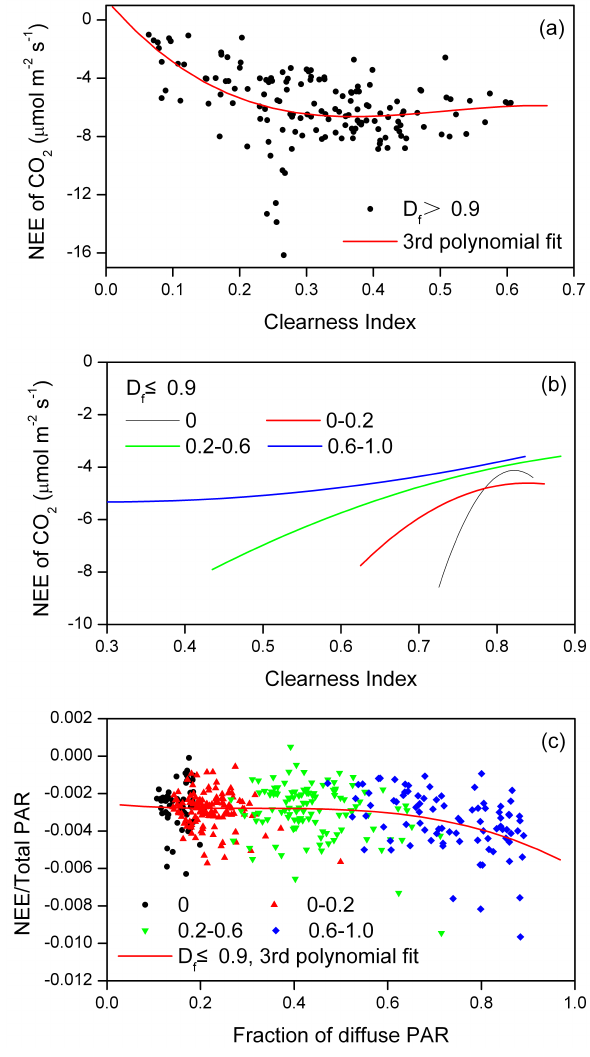
Fig. 7. Relationships between NEE of CO 2 and clearness index for D f > 0 . 9 (a) , and for D f ≤ 0.9 (b) , and the light use efficiency of vegetation as a function of fraction of diffuse PAR for D f ≤ 0 . 9 (c) grouping the data according to the cloudiness of 0, 0–0.2, 0.2–0.6 and 0.6–1.0 intervals; (a) 3rd polynomial fit ( n = 150, r 2 = 0 . 23, p < 0 . 01) is shown. (b) 2nd polynomial fits (0: n = 58, r 2 = 0 . 15, p < 0 . 01; 0–0.2: n = 129, r 2 = 0 . 07, p < 0 . 01; 0.2–0.6: n = 115, r 2 = 0 . 07, p < 0 . 05; 0.6–1.0: n = 86, r 2 = 0 . 05, p < 0 . 05 ) are shown, (c) 3rd polynomial fit ( n = 388, r 2 = 0 . 11, p < 0 . 01) is shown for all the